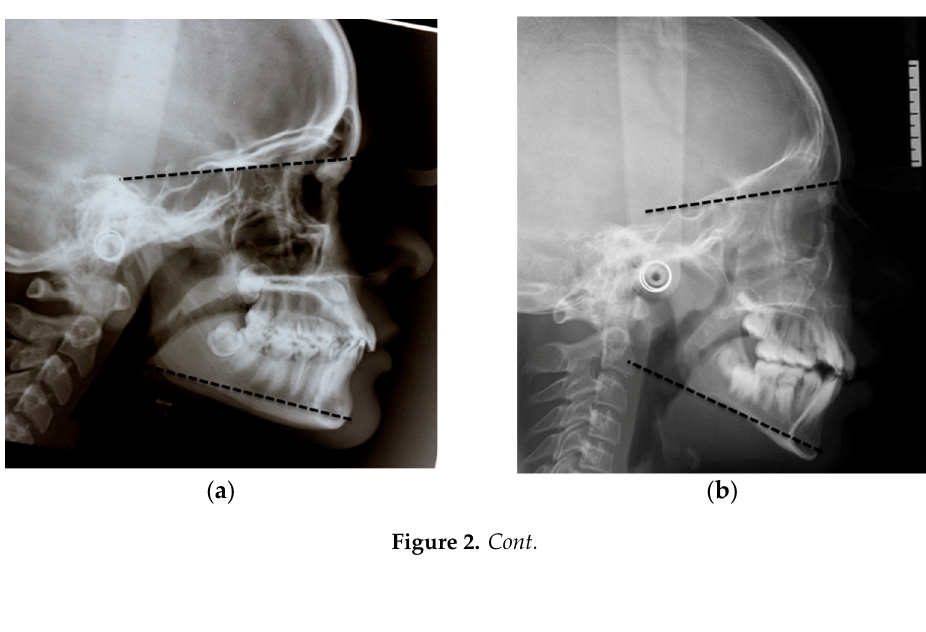
Figure 1. ( a ) Cephalometric analysis and landmarks. Landmarks: A (Point A), most posterior point of the frontal concavity of the maxillary between the anterior nasal spine and the alveolar processes; N (Nasion), most anterior point of the junction of the nasal and frontal bone (frontonasal suture); S (Sella), centre of the hypophyseal fossa; Go (Gonion), midpoint of the curvature at the angle of the mandible; Co (Condylion) the highest and most posterior point on the contour of the mandibular condyle; Pg (pogonion), the most anterior point of the symphysis; Gn (Anatomical gnathion), point of the mandibular symphysis on the facial axis; and Me (Menton), most inferior point of the mandibular symphysis. ( b ) Reference: NA (Nasion-point A line) line through N and A; NPg (Nasion-Pogonion line) line through N and Pg; SN (Sella-Nasion line) line through S and N; GoGn (Mandibular plane) line through Go and Gn; CoGo (condylar axis) line through Co and Go; and GoMe (Mandibular base) line through Go and Me.